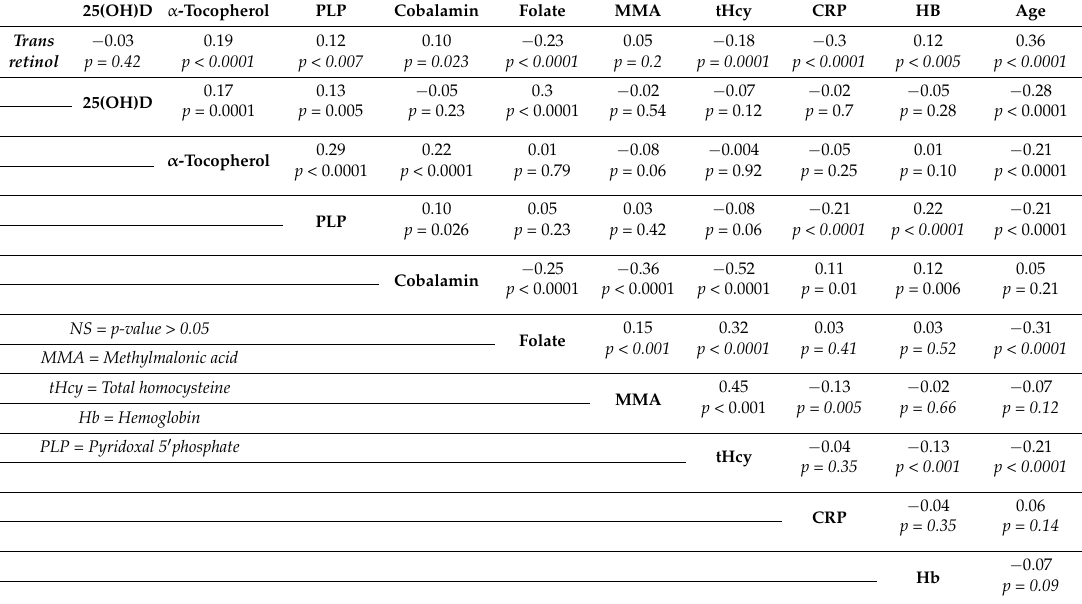
Table 6. Correlations for vitamin status, MMA, tHcy, CRP, Hb and age among healthy infants